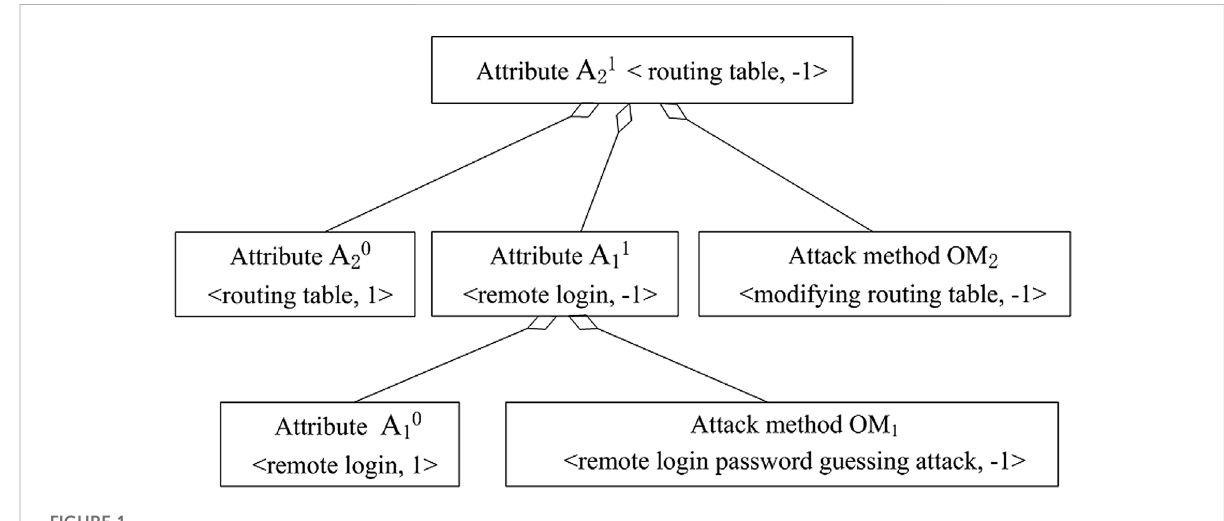
FIGURE 1 The diagram of object-oriented method for the cyber-attack